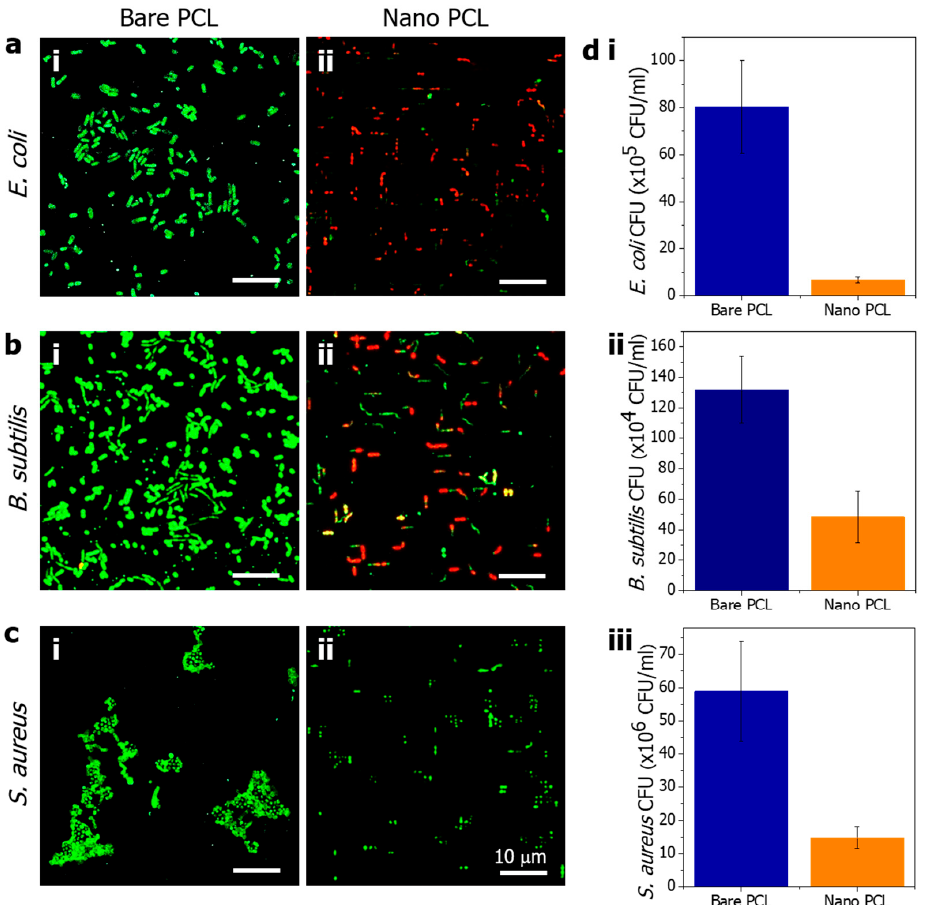
Figure 5. Confocal images of ( a ) E. coli , ( b ) B. subtilis and ( c ) S. aureus cultured on bare and nanopil- lared PCL samples (green: live cells, red: dead cells). ( d ) CFU of ( i ) E. coli , ( ii ) B. subtilis , and ( iii ) S. aureus cultured on the bare and nanopillared PCL samples for 18 h.